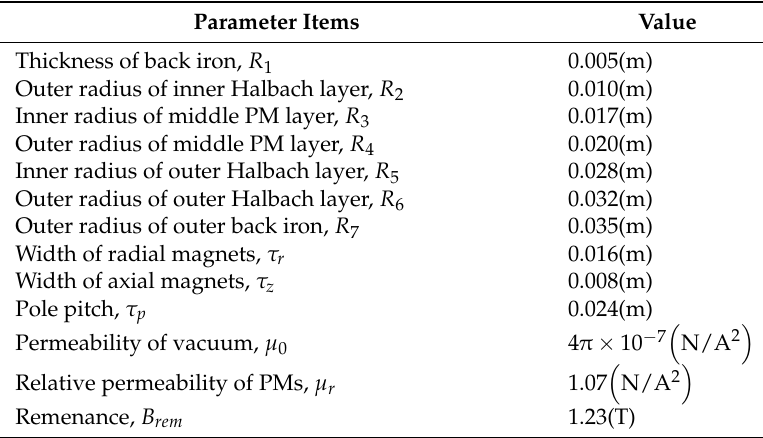
Table 2. Major parameters of the linear machine for numerical